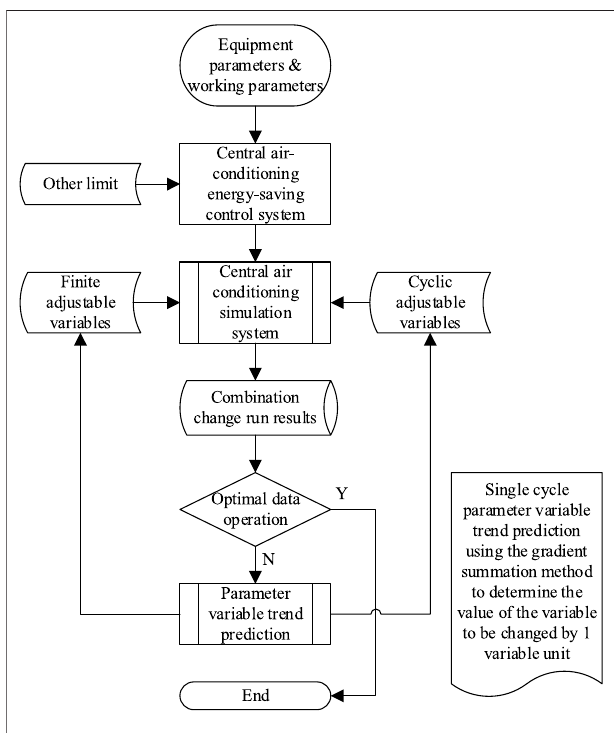
FIGURE 5 | Optimized logic of system calculation